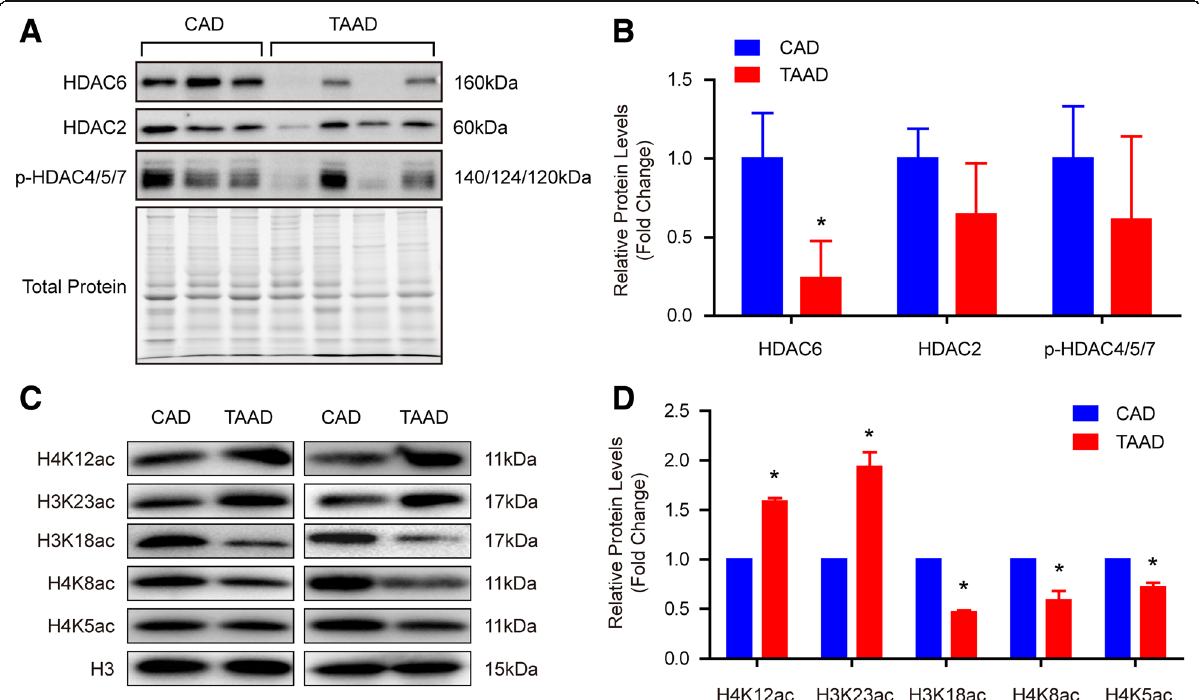
Fig. 1 HDAC6 protein level was decreased in aorta of TAAD patients. a and b The protein levels of histone deacetylases were detected by western blot ( n = 6 pooled samples per group), * p < 0.05 vs. CAD. c and d The acetylation levels of H4K12, H3K23, H3K18, H4K8, H4K5 were evaluated by western blot in the aorta of CAD and TAAD patients ( n = 6 pooled samples per group), * p < 0.05 vs.